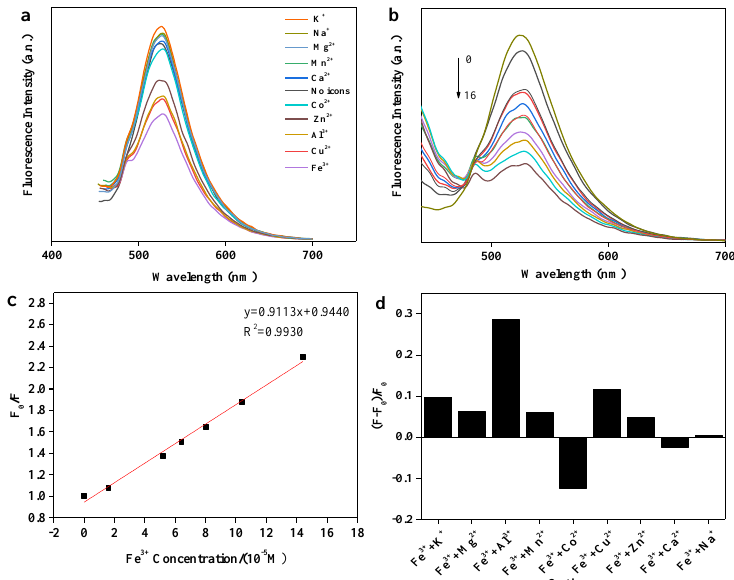
Figure 3. Fluorescence sensing of BRF towards Fe 3+ . ( a ) Fluorescence emission spectra of BRF with the addition of different metal ions; ( b ) fluorescence emission spectra of BRF quenched by various Fe 3+ concentrations (0–0.16 mM); ( c ) Stern–Volmer plot for fluorescence quenching of BRF after the addition of Fe 3+ (0–0.16 mM); ( d ) the interference of other metal ions on the fluorescence detection of BRF to Fe 3+ . F 0 and F represent the fluorescence intensity of BRF-Fe( Ⅲ ) system before and after the addition of other metal ions.